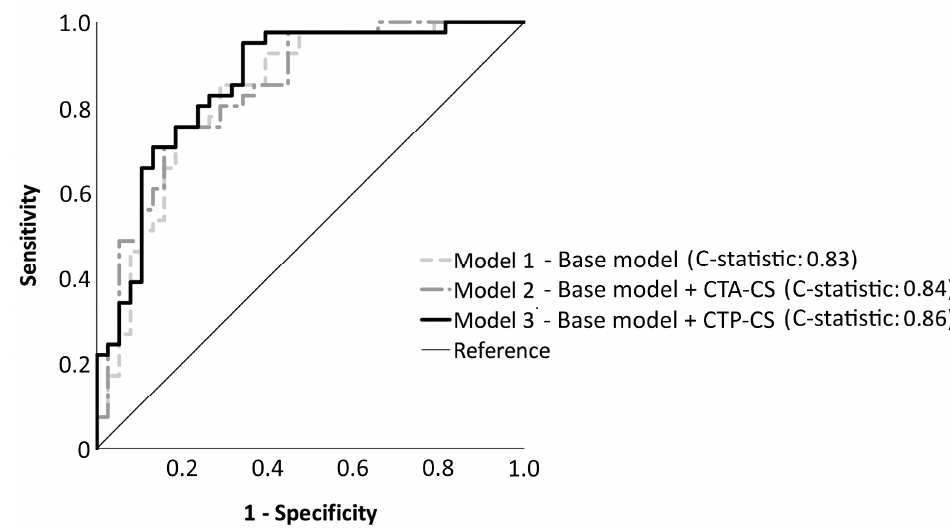
Figure 3. Receiver-operating characteristics curves for three different models for predicting favorable functional outcomes (mRS 0–2). Model 1 is the base model with baseline prognostic factors as the independent variables: age, stroke severity (NIHSS), time from onset to groin puncture, history of hypertension, diabetes mellitus, and previous strokes. Model 2 and model 3 are model 1 with the addition of collateral scores as assessed by CTA and CTP, respectively. The C-statistic for model 1, model 2, and model 3 respectively are 0.83 (95% CI, 0.74–0.92), 0.84 (95% CI, 0.75–0.93), and 0.86 (95% CI, 0.77–0.94). There are no significant differences between the C-statistics of the models.